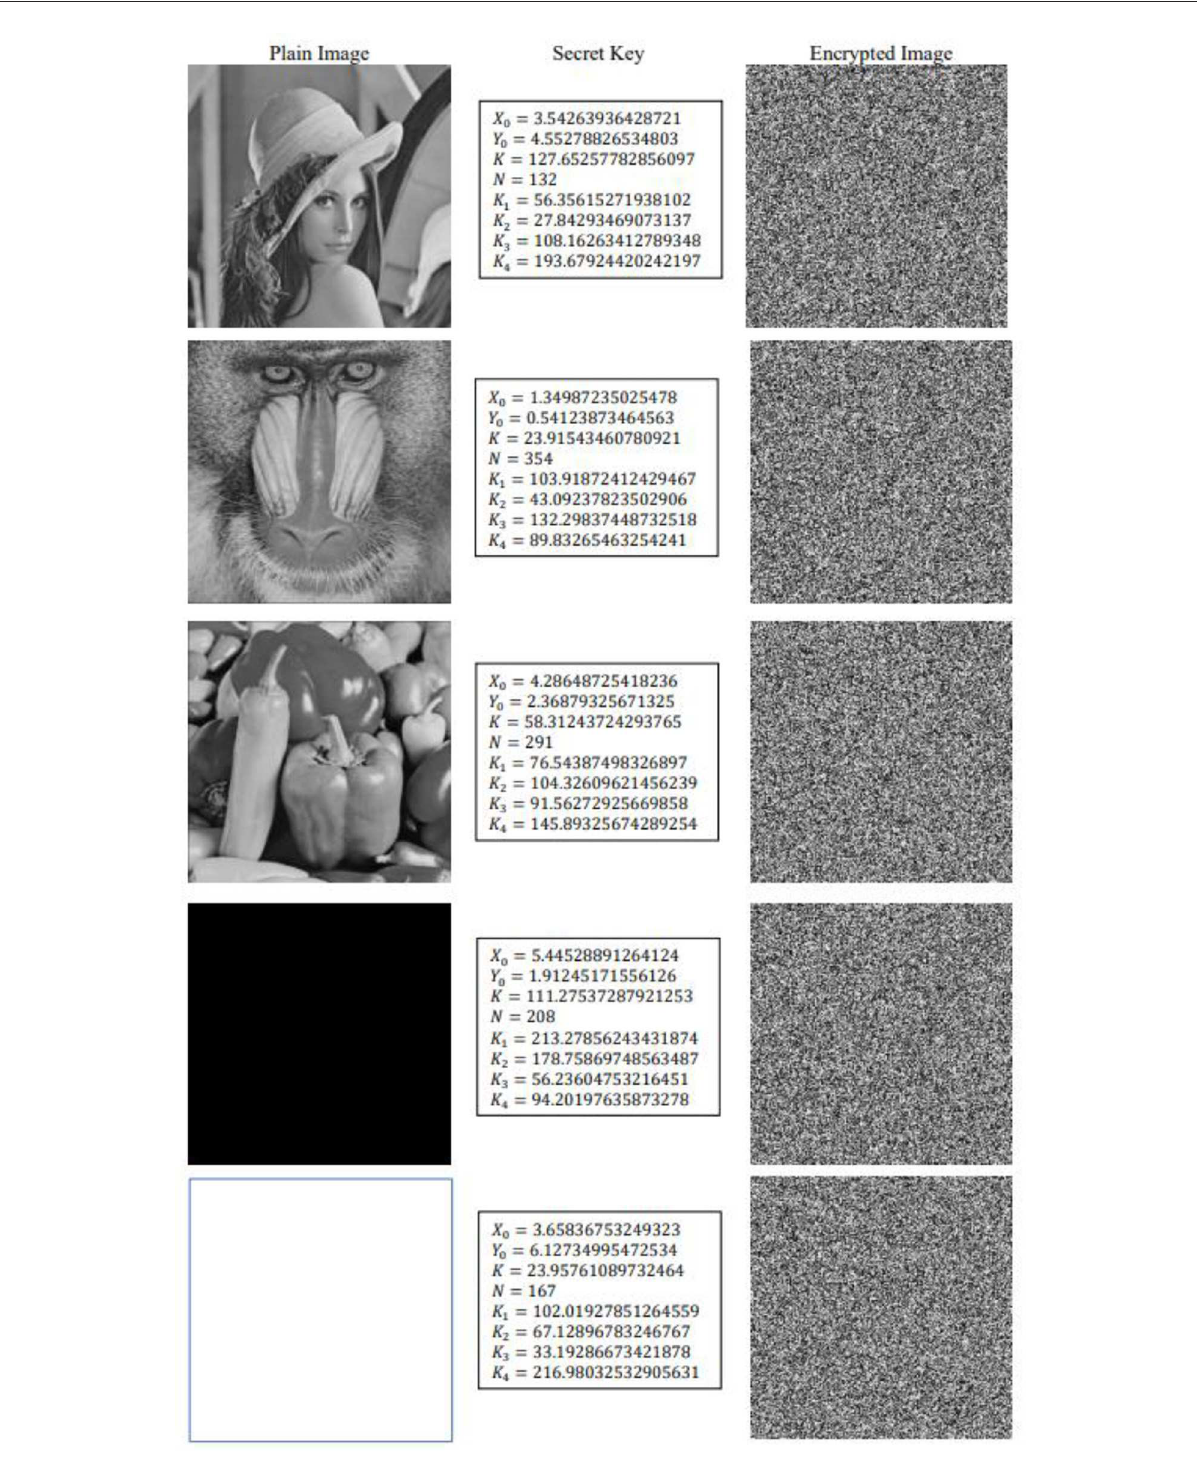
FIGURE4 Plain images, corresponding secret keys and cipher